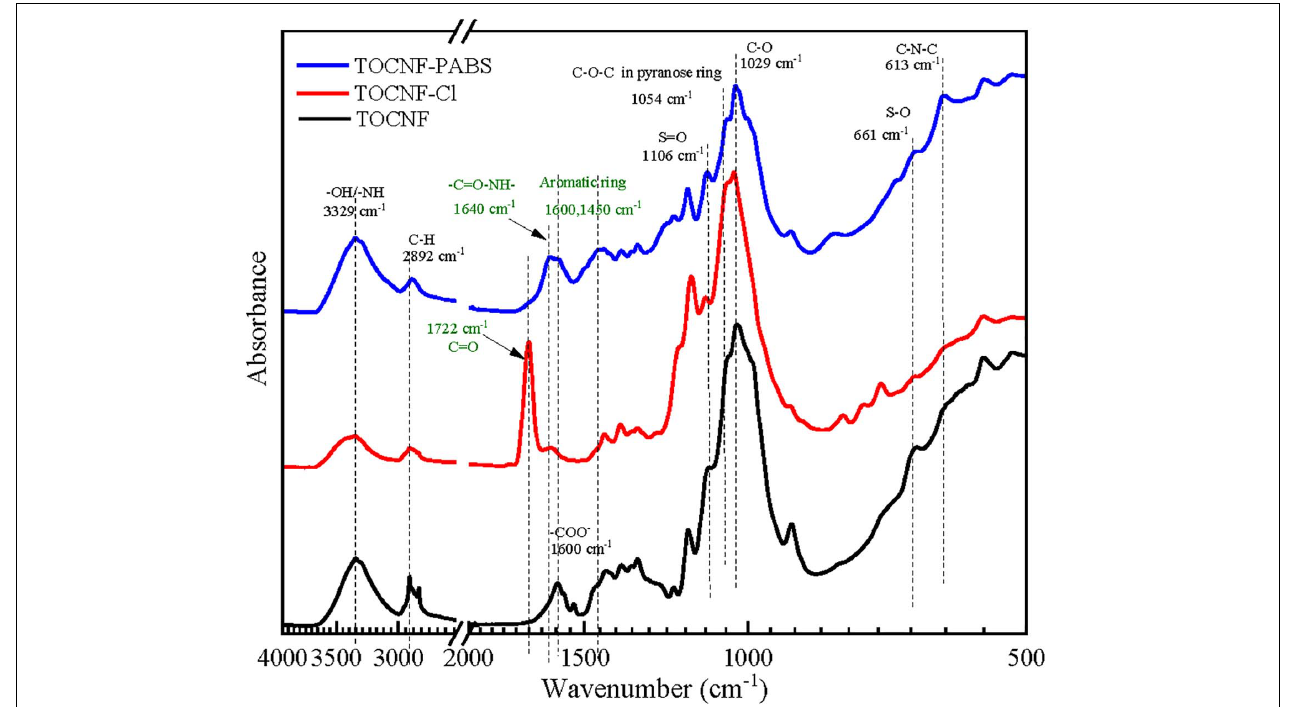
FIGURE 1 | Fourier transform infrared (FT-IR) spectra of TOCNF, TOCNF-Cl, and